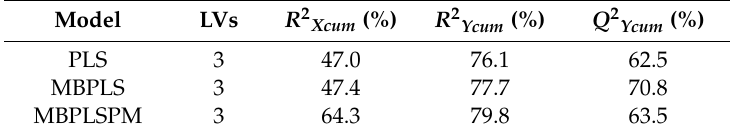
Table 8. Diagnostics of PLS, MBPLS and MBPLSPM models on the PNS IRT